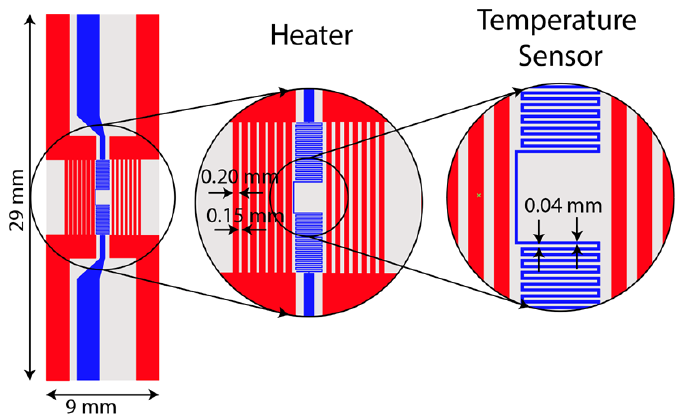
Figure 3. Photograph and schematic of the integrated heater and temperature sensor on a glass substrate.